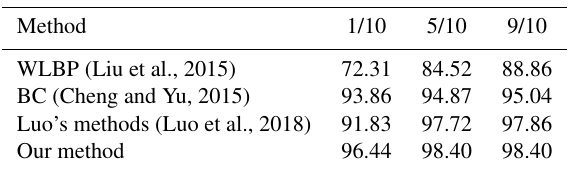
Table 1. Classification accuracy (%) of the SWIMCAT dataset ob- tained by different methods.